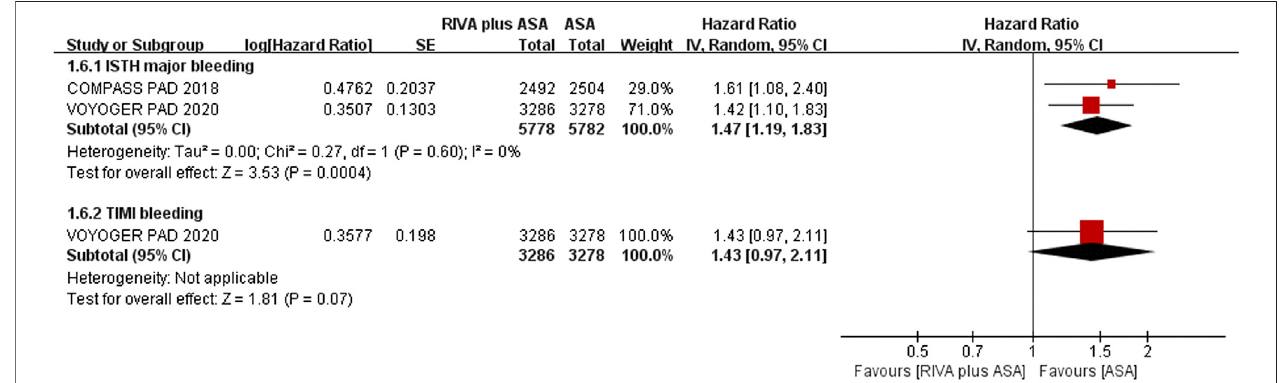
FIGURE 5 | Forest plot of the risk of major bleeding in peripheral arterial disease patients treated with rivaroxaban plus aspirin and aspirin. ISTH, International Society on Thrombosis and Haemostasis; TIMI, Thrombolysis in Myocardial Infarction; RIVA, rivaroxaban; ASA, aspirin; IV, inverse variance VOYOGER PAD, Vascular